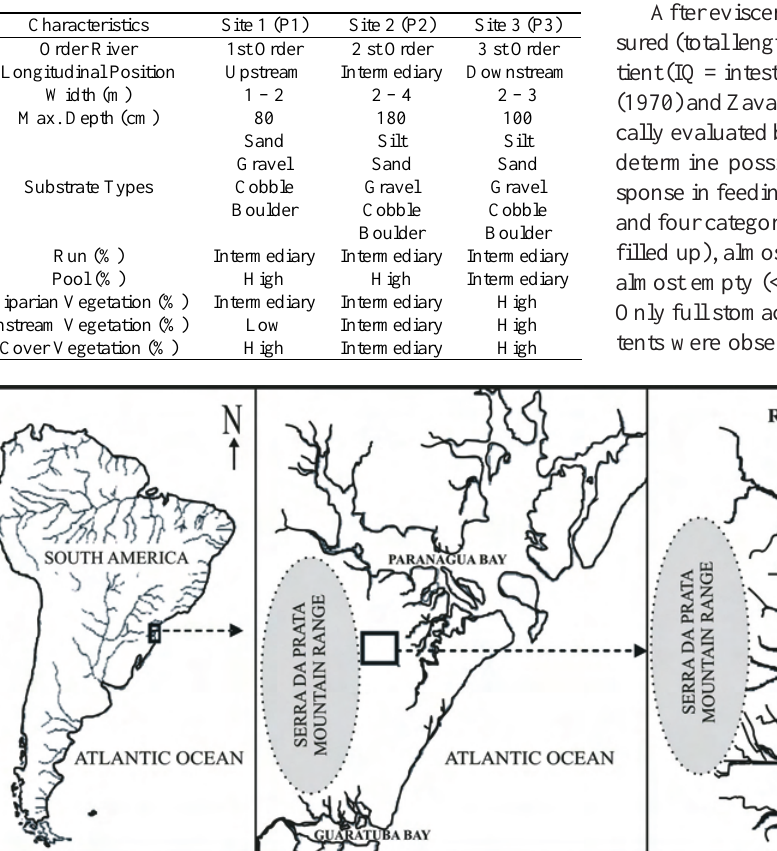
Table 1. Major characteristics of the three sampled sites along the rio Ribeirão basin, a Neotropical stream of Serra do Mar, Atlantic Forest, in southern Brazil.